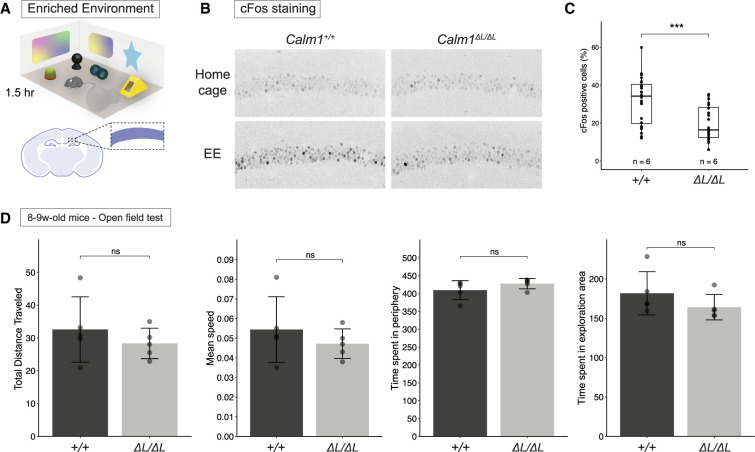
Calm1-L loss reduces hippocampal IEG expression in response to enriched environment exposure. (A) Graphic illustration of enriched environment used in this study and the CA1 region shown in B. (B) Representative images showing EE-induced expressions of cFos in Calm1+/+ and Calm1ΔL/ΔL CA1. (C) Percentages of cFos-positive cells in whole CA1 region was quantified in FIJI/ImageJ. Significance was determined using a t-test, (***) P < =0.001. n = 6 mice (two hemispheres in two brain sections for each mouse). (D) Levels of total distance traveled, mean speed, time spent in periphery and exploration areas of Calm1+/+ and Calm1ΔL/ΔL mice were compared using open field test. Significance was determined using a t-test in n = 5 mice; ns: P > 0.05.